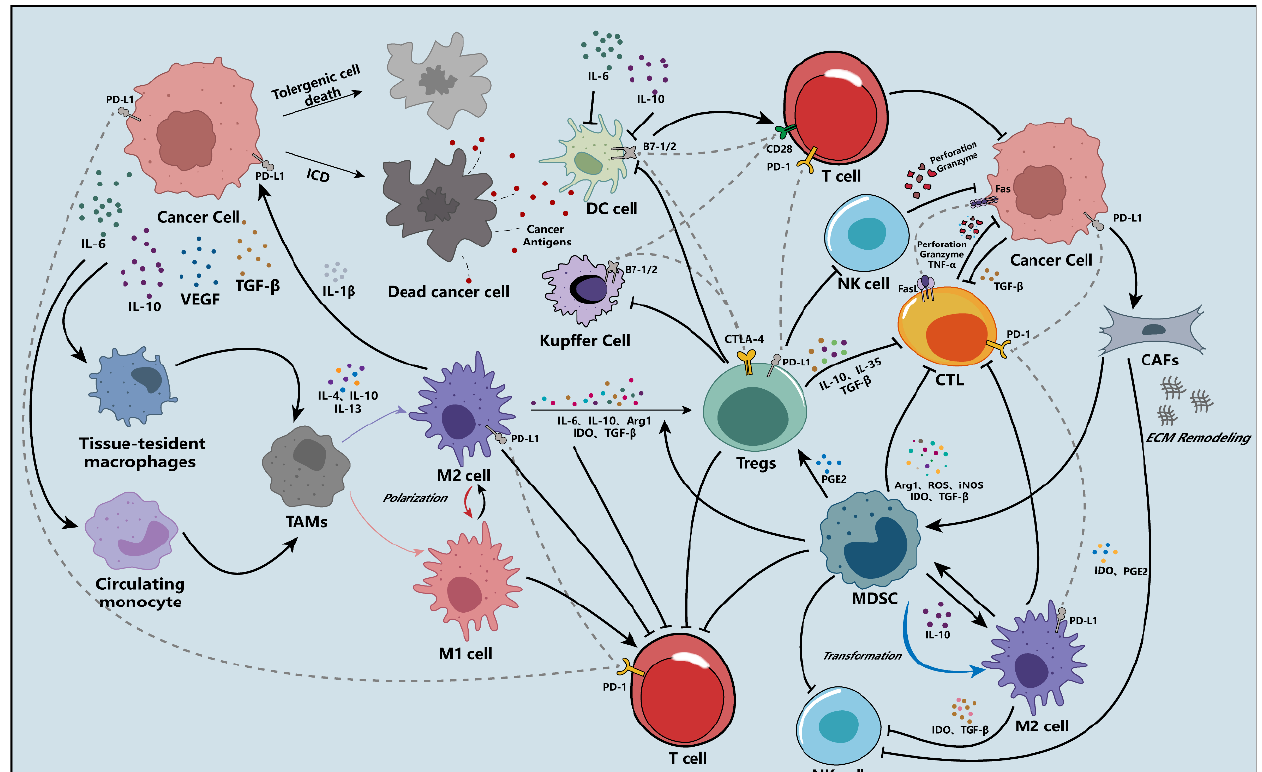
Figure 1. A schematic overview of the mechanisms of the tumor immunosuppressive microenvironment (TIME) in the hepatocellular carcinoma (HCC).